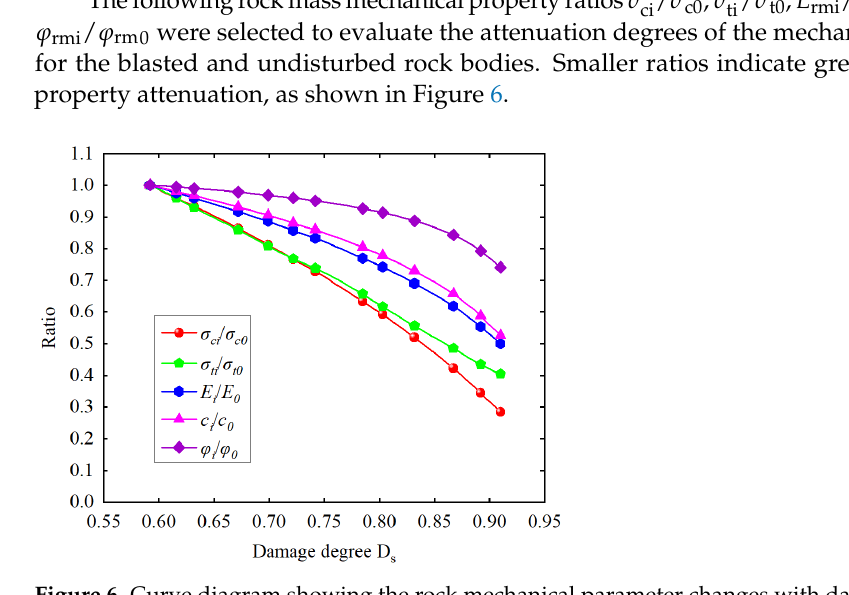
Figure 6. Curve diagram showing the rock mechanical parameter changes with damage degree.